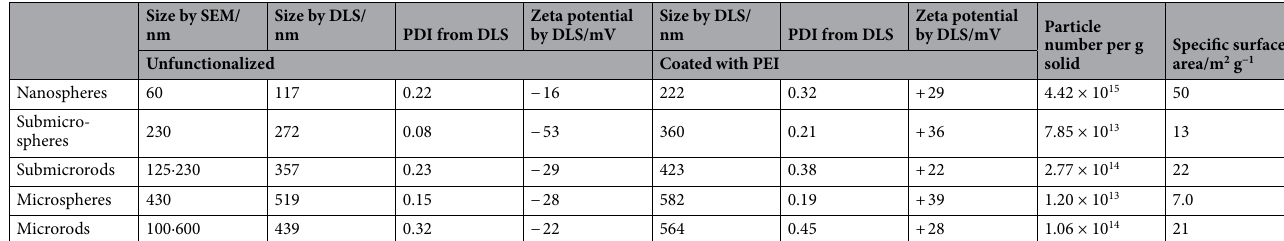
Table 1. Physicochemical characterization data of the silica particles, both unfunctionalized and coated with polyethyleneimine (PEI). All particles were completely X-ray amorphous. The particle numbers and the specific surface area were computed from the SEM particle size data. DLS was performed in water at pH